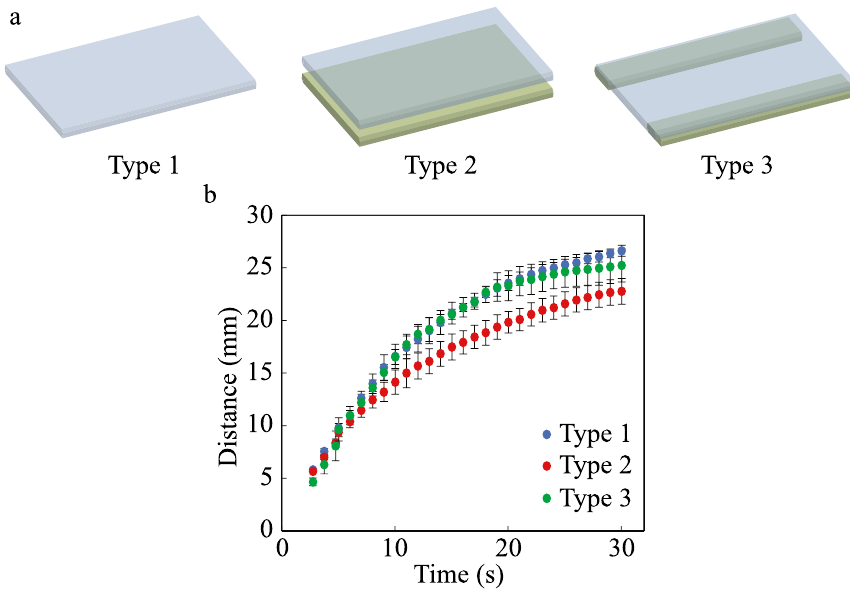
Figure 8. The schematical representation of the supporting layer is shown here, ( a ) for the three cases, Type 1, Type 2, Type 3. ( b ) Comparison of the experiments of distance travel by the liquid in all the three different